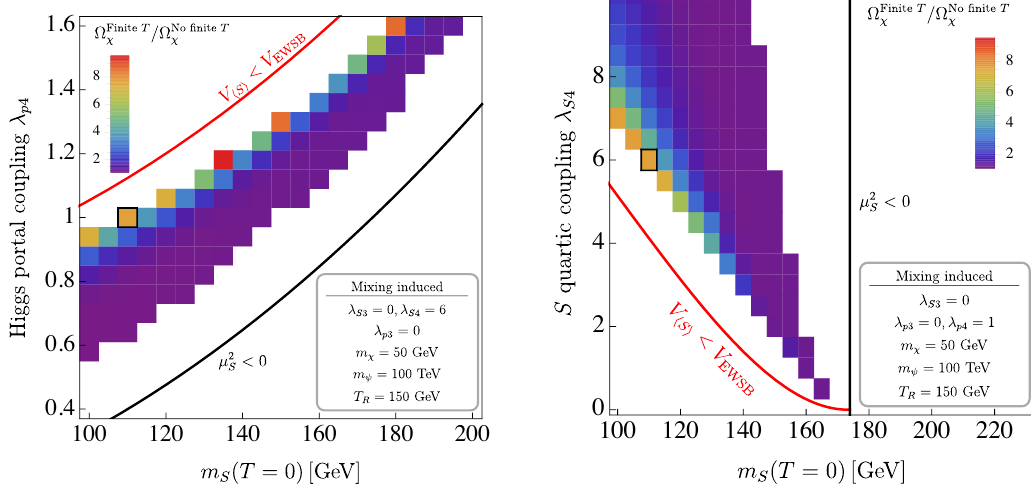
Figure 11 . The ratio of the DM abundance including over ignoring (cid:12)nite temperature e(cid:11)ects in the mixing induced scenario. We show a cut through the parameter space in the plane spanned by the zero temperature mass of S , m S ( T = 0), and the quartic Higgs portal coupling (cid:21) p 4 (left) and a slice of parameter space in the m S ( T = 0){ (cid:21) S 4 plane (right). We see that the impact of thermal e(cid:11)ects is largest at large portal coupling (cid:21) p 4 and small self-coupling (cid:21) S 4 , where the h S i 6 = 0 phase lasts longer. The black outline indicates the point considered in (cid:12)gure